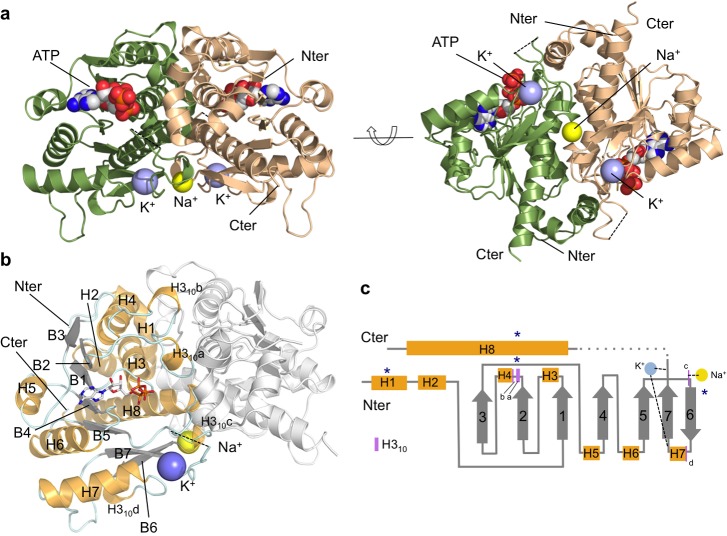
X-ray crystallographic structure of the binary complex TcdA at 1.77-Å resolution in complex with ATP.
a Ribbon representation of the TcdA homodimer structure in two orientations related by a 90° rotation depicting each subunit in a different color (green or wheat). Two K+ and one Na+ cations are shown as violet and yellow spheres, respectively. The Na+ ion is located right at the homodimeric interface and its coordination sphere comprises amino acid residues from both monomers and water molecules. ATP is bound in a conserved surface pocket (shown as a space-filling model in CPK colors). b Description of secondary structural elements of TcdA monomer. Helices are shown in gold (α-helices are labeled H1-H8 and 310 helices H310a-d), strands in white (B1-B7), and loops in light cyan. c Annotated schematic representation of TcdA topology. Helices and strands are depicted as in b, except for 310 helices which are indicated with purple lines and labeled a-d. K+ and Na+ ions are shown as blue and yellow circles. Dashed lines delimit regions that interact with K+, and structures involved in TcdA dimerization are marked with dark blue asterisks.